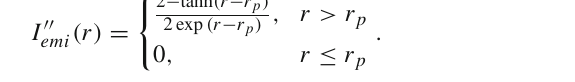
than 1, thereby this line is related to the lensing ring (with the photon ring included in), which represents the image of the back side of the disk that has been largely